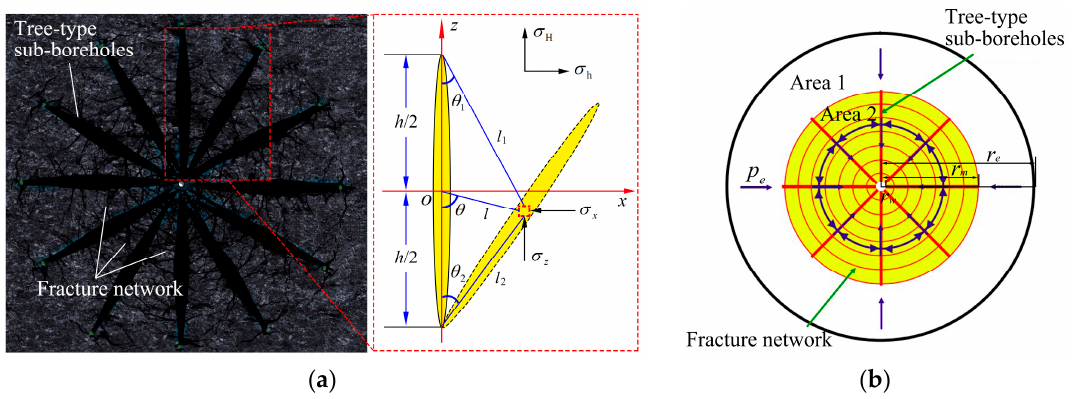
Figure 2. ( a ) Image of tree-type sub-boreholes and a diagram showing a two-dimensional plane strain model for the stress field around tree-type sub-boreholes; ( b ) Diagrammatic sketch showing the gas flow through a fracture network formed by tree-type drilling and fracturing.